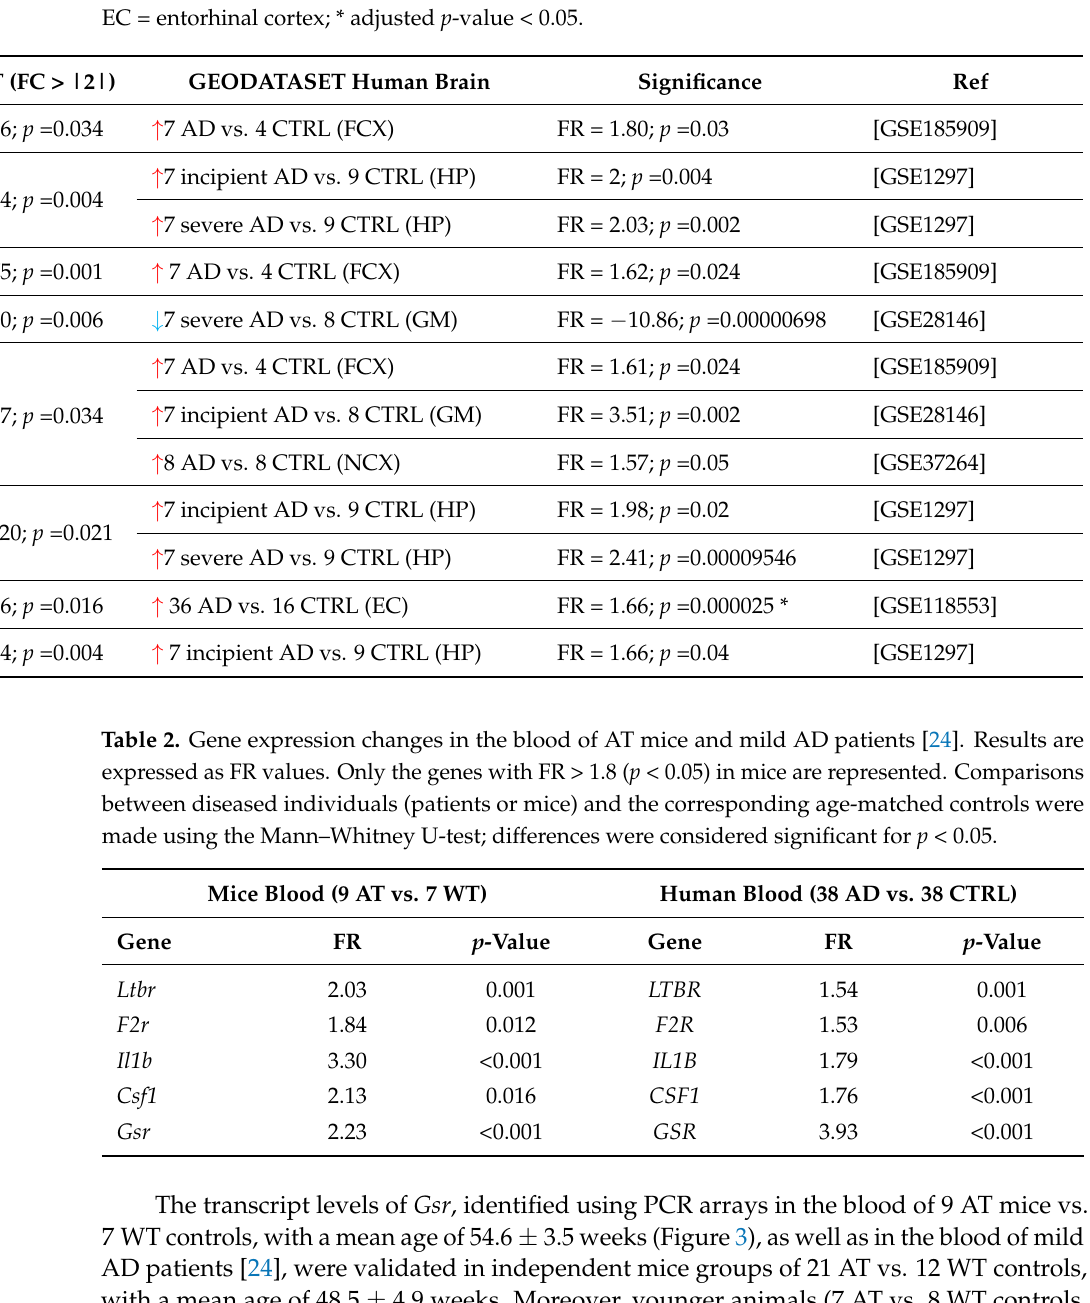
Table 1. Comparison of genes dysregulated in the hippocampus of AT mice (|FR| > 2, p < 0.05) and in post-mortem samples of AD brains from different microarray data sets (FR > |1.5| and nominal